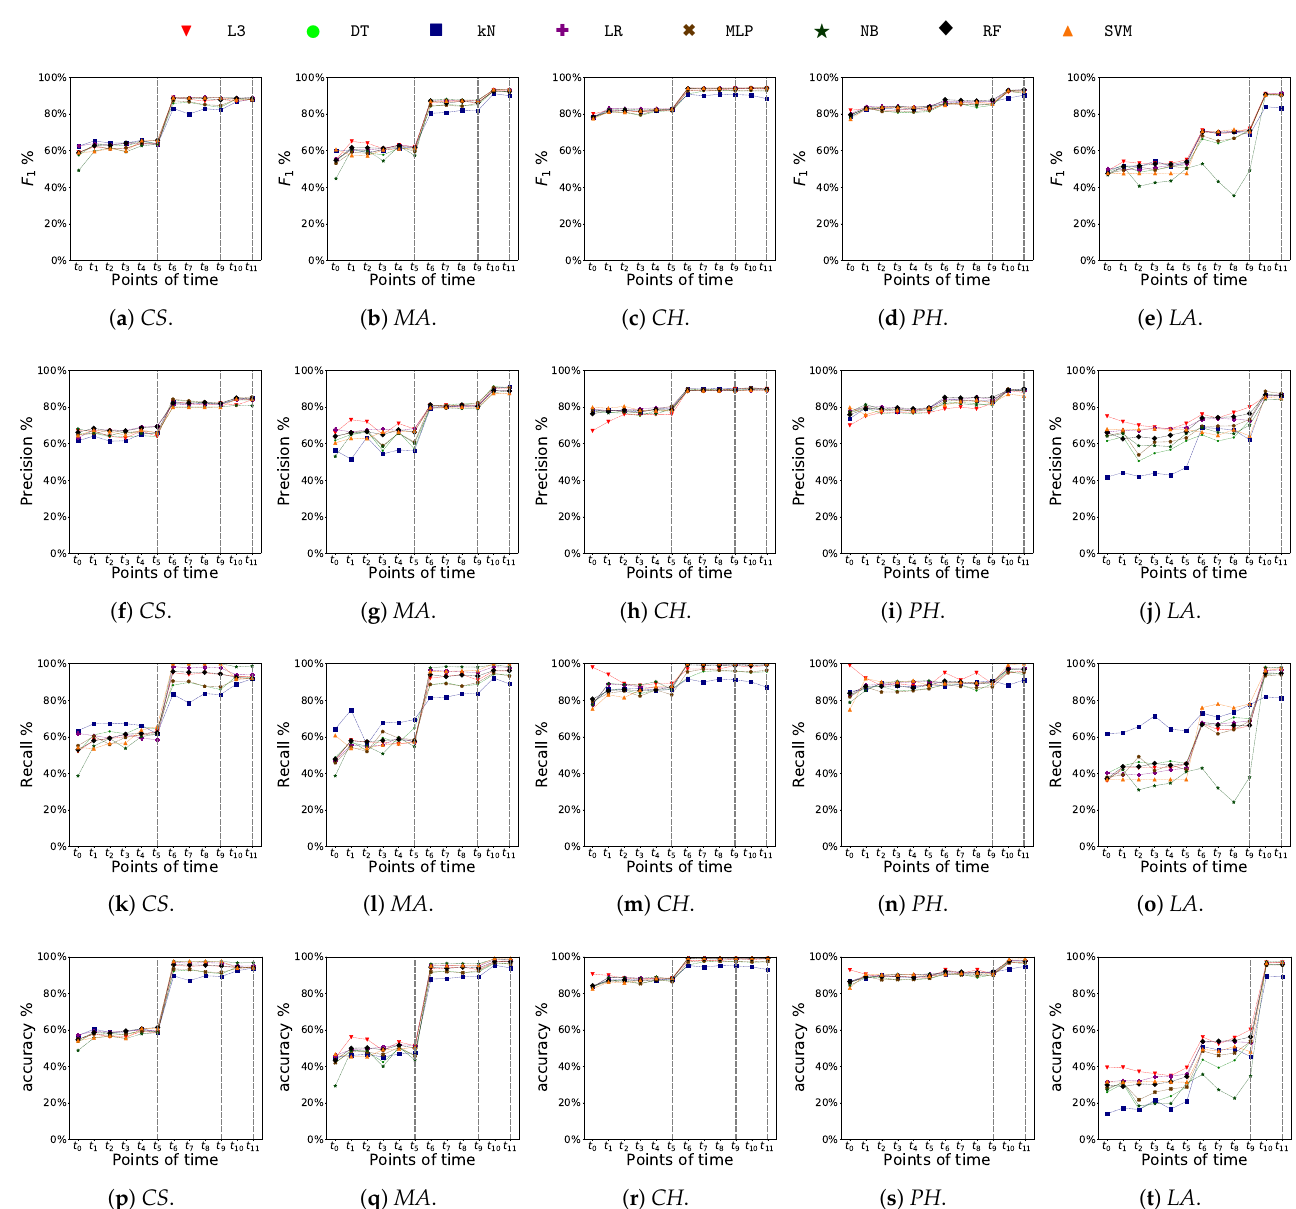
Figure 2. Algorithms’ comparison in terms of F1-score, precision, recall and balanced accuracy of class fail